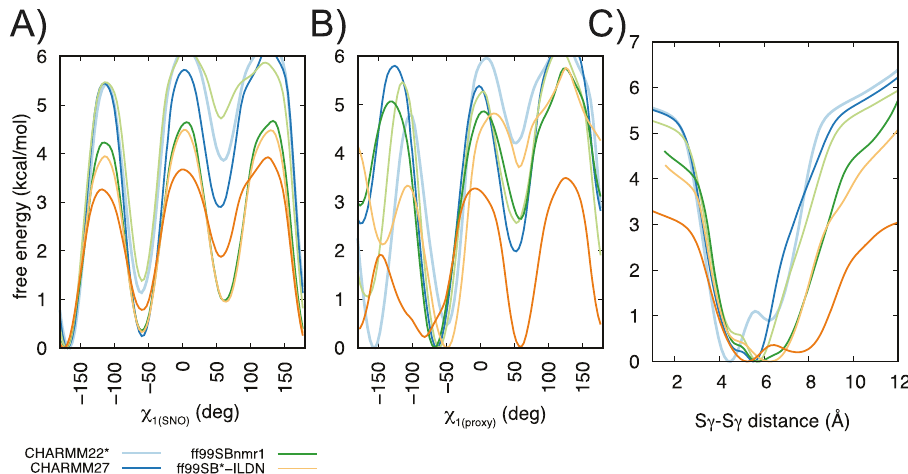
Fig. 2 Different MD force fi elds agree on the conformational preferences of the reduced form of the two cysteines of TRAP1 311 – 567 . The panels show the mono-dimensional free energy pro fi les associated with the collective variables ( A ) χ 1(SNO) , ( B ) χ 1(proxy) and ( C ) S γ -S γ distance for the metadynamics simulations. We performed metadynamics using CHARMM22* (light blue), CHARMM27 (dark blue), CHARMM36 (light green), ff99SBnmr1 (dark green), ff99SB*-ILDN (light orange), GROMOS54a7 (dark orange) force fi elds. Overall, the MD force fi elds agree that the SNO site and the proximal cysteine could populate three possible rotameric states for their χ 1 dihedrals, with the plus state as the least favorable one. Furthermore, they agree in describing the distances between the two cysteines with minima in the free energy landscape at a distance of 4 – 6.5 Å. We observed that GROMOS54a7 is the only exception showing a less stable behavior, with χ 1(proxy) equally populating all the dihedral states and the S γ -S γ distance sampling minima at distances higher than 7